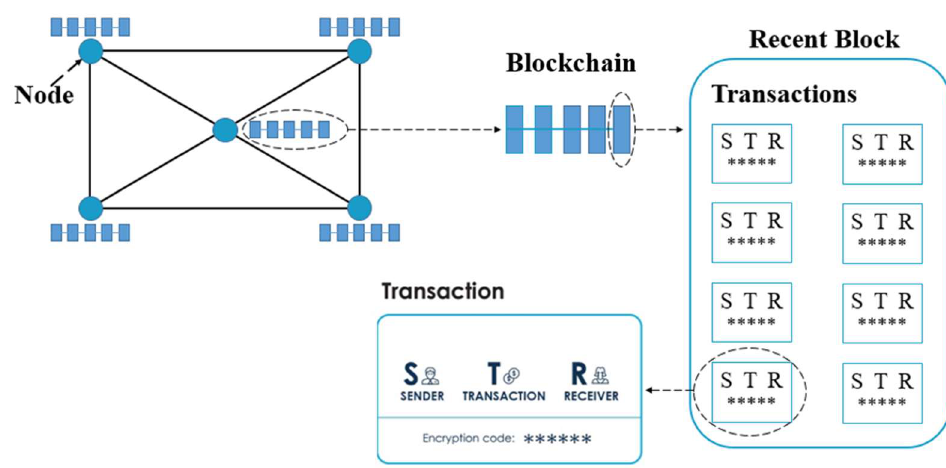
Figure 1. A Simplified Distributed Ledger Network.